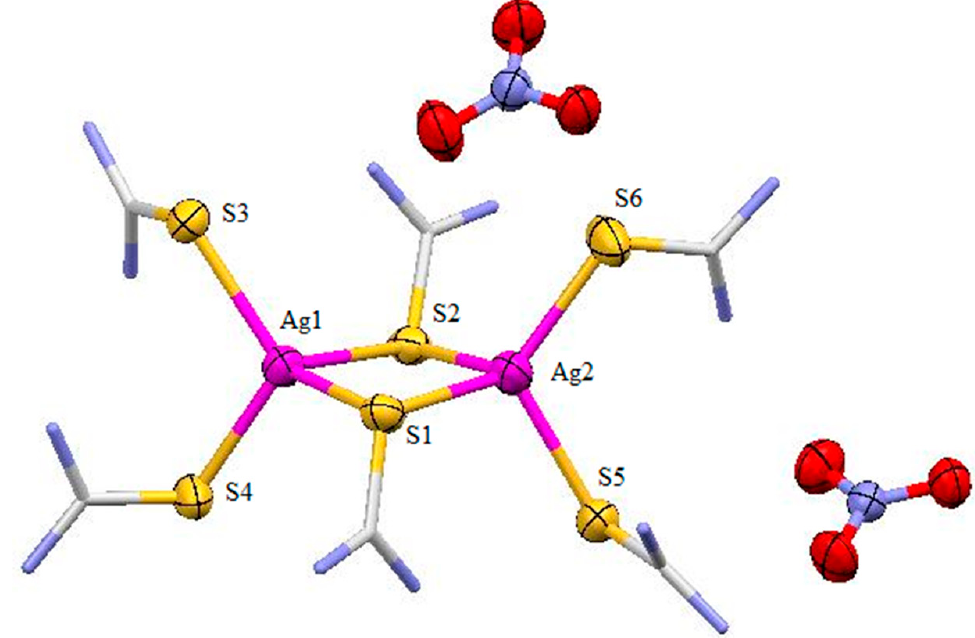
Figure 6. The molecular structure of compound 2 , only non-carbon atoms are numbered. Ellipsoids are drawn at 50% probability level, hydrogen atoms are omitted and carbons are represented by capped sticks.